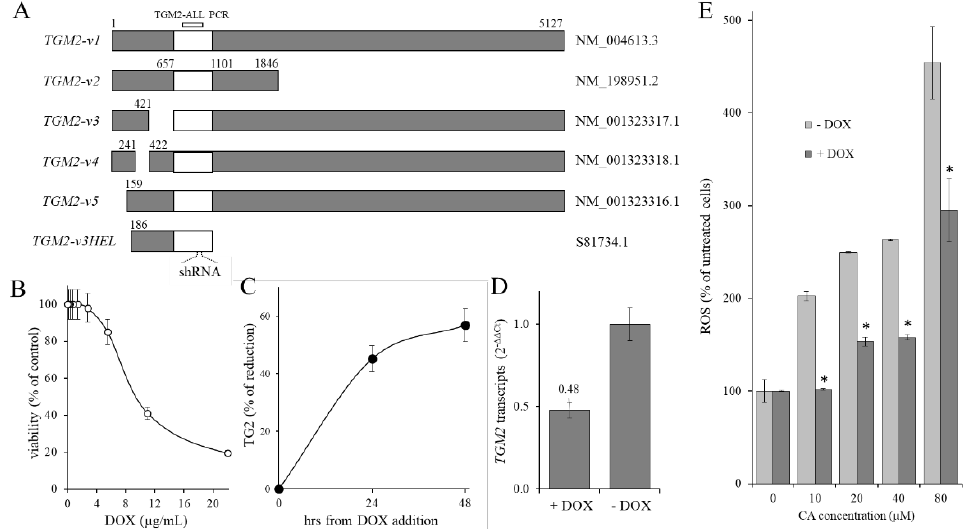
Figure 4. Effect of TGM2 transcripts knock-down on ROS production. ( A ) BLAST alignment of the known TGM2 transcript variants. The homology region 657–1101 (numbers refer to TGM2 transcript variant 1) common to all TGM2 transcript variants was represented as a white box. ( B ) Dose-dependent cytotoxic effect of DOX on KD-TGM2 cells. Viability was measured by MTT assay. 95% of cells were viable by using DOX at 4 µg/mL. DOX = doxycycline. Data are expressed as arithmetic mean ± SD. ( C ) Flow cytometric analysis of time-dependent expression of TG2 protein in KD-TGM2 cells after the addition of DOX 4 µg/mL. Data are expressed as arithmetic mean ± SD ( D ) RT-qPCR analysis of all variants of TGM2 transcripts expression measured after 48 h of induction. The PCR was performed using the TGM2-ALL primers. Data are expressed as arithmetic mean ± SD. ( E ) Dose-dependent effect of CA administration on TGM2 transcripts level in KD-TGM2 cells not induced or induced to express the shRNA targeting TGM2 transcripts. TGM2 transcripts expression was measured after 48 h of induction by the primer couple TGM2-ALL. Data are expressed as arithmetic mean ± SD. Asterisks indicate significant differences ( p < 0.05) produced by CA treatment on cells in which knockdown of TG2 (+DOX) transcripts was induced compared to cells with normal levels of tran- scripts ( − DOX).